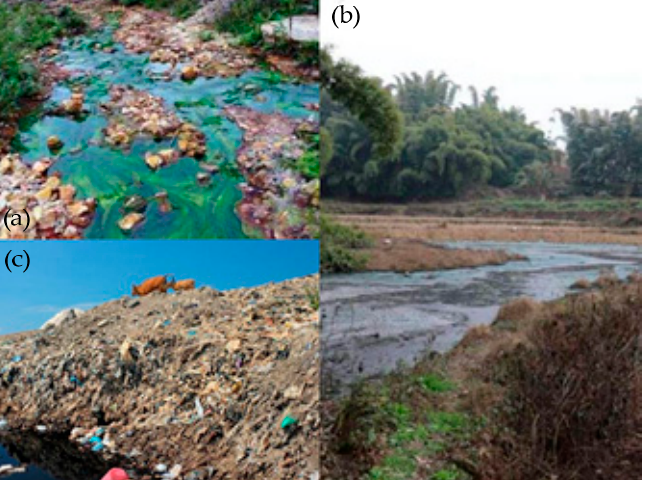
Figure 1. Soil pollutions in China. Note : ( a ) industrial heavy metal pollution, ( b ) non-point source pollution of arable land, and ( c ) domestic waste pollution in rural areas. (Pictures sourced from https://image.baidu.com/ and accessed on 31 December 2020.)